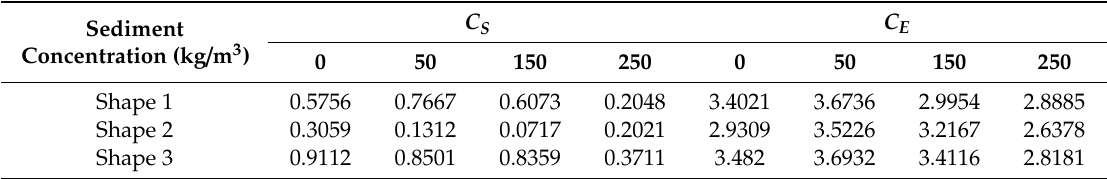
Table 2. Skewness coe ffi cient C S and kurtosis coe ffi cient C E at 2.20 m water head.